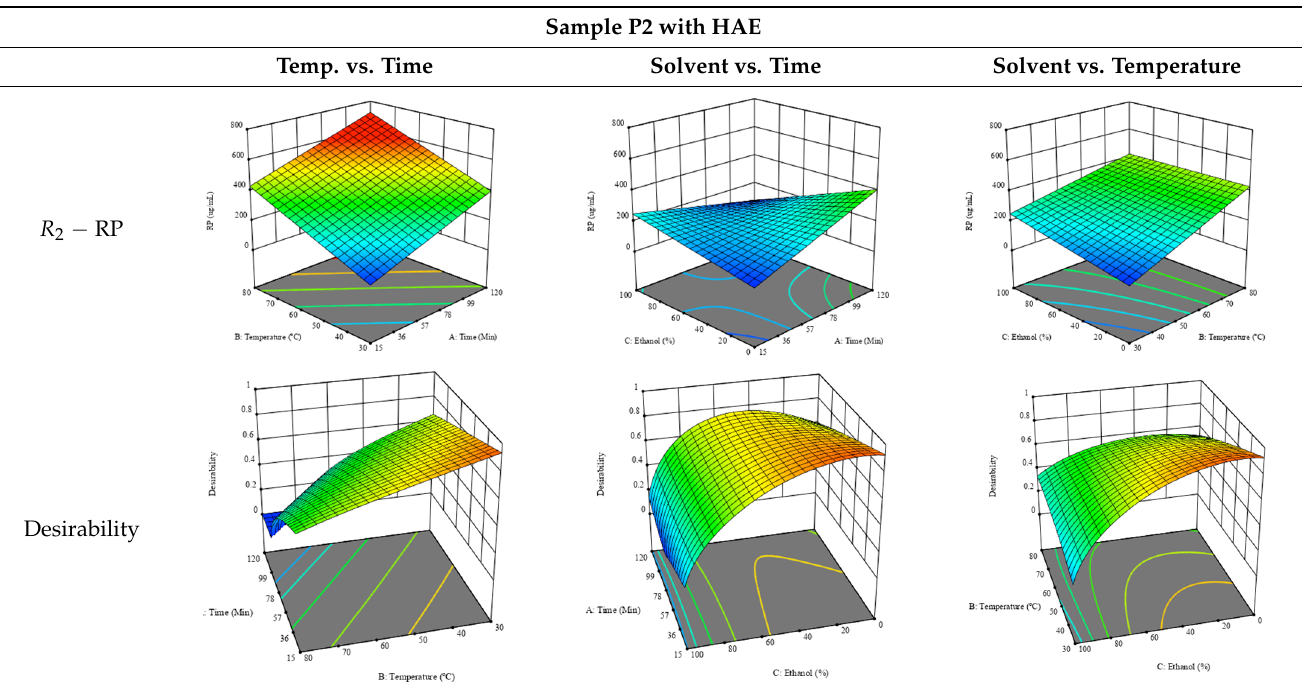
Sample P2 with HAE